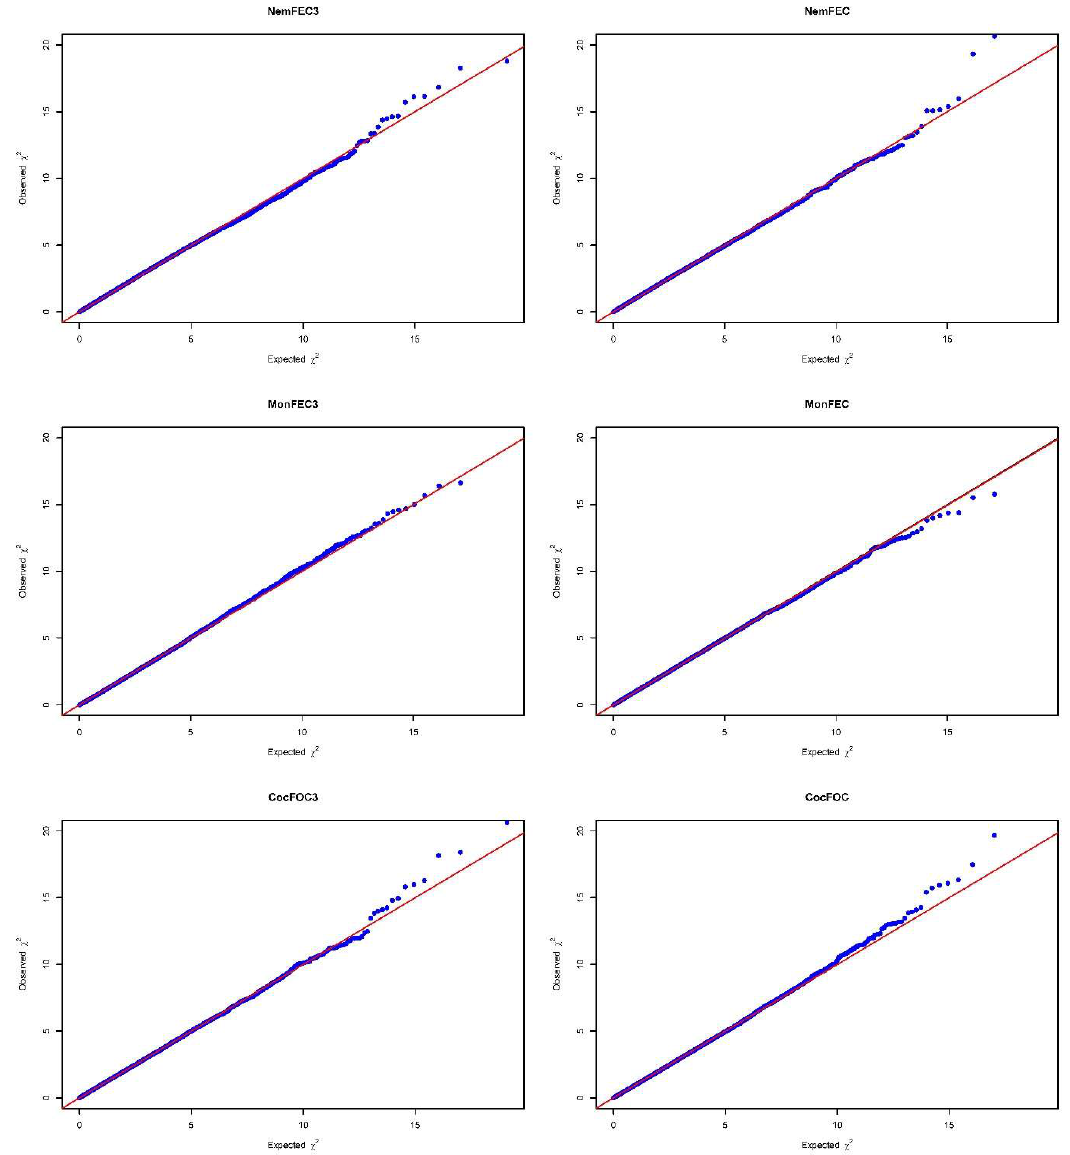
Figure 1. Quantile-quantile (Q-Q) plots of genome-wide association studies (GWAS) for the parasite resistance traits.